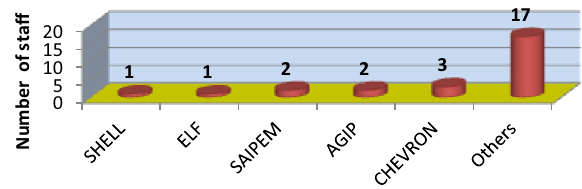
Fig. 1 The number of surveyed Multinationals in Rivers State Nigeria. Demographic information of multinationals in Rivers State.